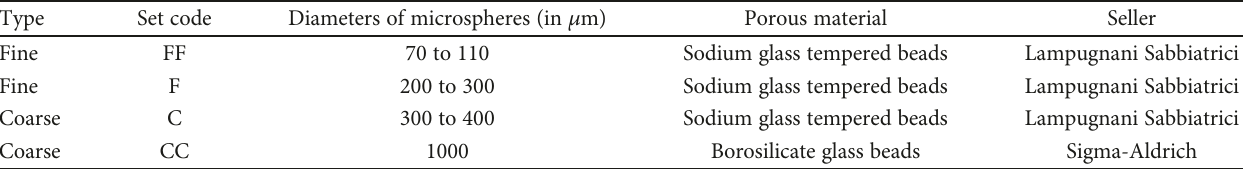
Table 1: Characteristics of the glass beads used for the